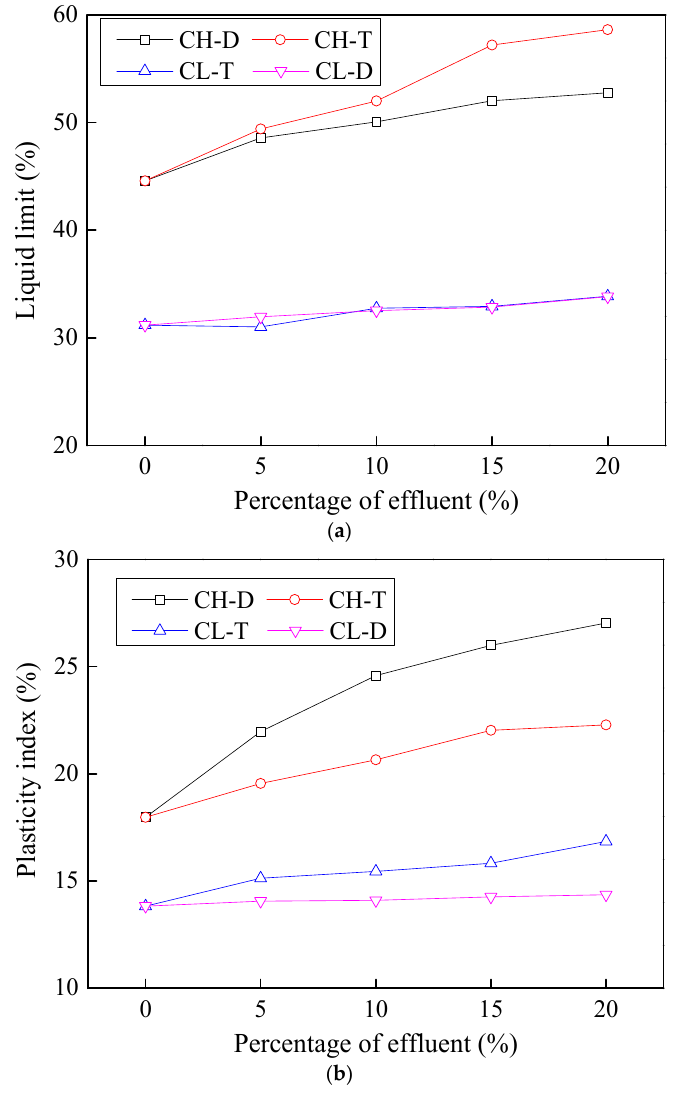
Figure 6. Effects of industrial effluents on ( a ) liquid limit and ( b ) plasticity index of cohesive soils.